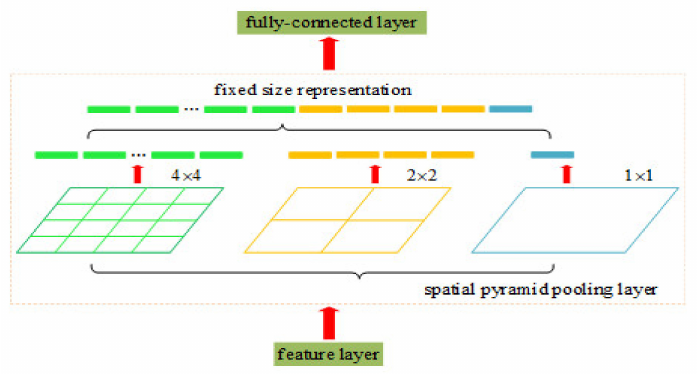
Figure 2. SPP network structure